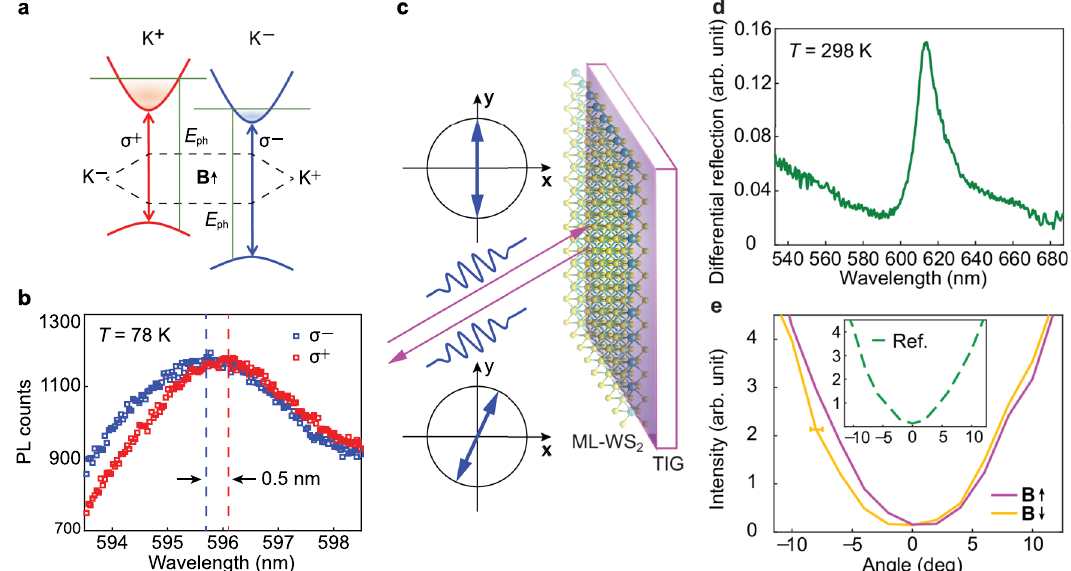
Fig. 3 Magneto-optical effects in a monolayer WS 2 on TIG. a The time-reversal symmetry breaking with an out-of-plane exchange magnetic fi eld provided by TIG induces a spectral splitting and an intensity difference between σ − (blue) and σ + (red) in the ML-WS 2 under the pumping of E ph . b The observed splitting of ~0.5 nm (~1.7 meV) corresponds to an exchange magnetic fi eld of ~7 T at the temperature of 78 K from the TIG. The splitting is estimated to be ~0.2 nm that is hardly measurable in spectra with the reduced exchange magnetic fi eld of ~2.7 T at 298 K. c An alternative method to characterize the magneto-optical effect (Fig. 1C) is using the rotation of linear polarization (blue arrows) of light upon re fl ection. d A differential re fl ection spectrum, de fi ned as the difference in re fl ectance of the sample (WS 2 ) and substrate (TIG) normalized to that of a reference (silver mirror), consists of a peak of light-matter interaction at the wavelength of ~617 nm. e Analysis of the polarization of re fl ected light from WS 2 at 617 nm with up (purple) and down (yellow) magnetic moments. The 0° represents that the polarization of the output and input light is the same. The minima of curves designate the polarization of the outgoing light showing a rotation angle of ~2° compared to that of the input light. By fl ipping the exchange magnetic fi eld ( B ↑ and B ↓ ), the rotation angle changes the sign indicating that the rotation is due to the magneto-optical effect. In the absence of the exchange magnetic fi eld, the polarization of the light re fl ected from a reference silver mirror (inset) is the same as that of the input light, which manifests as the minimum at 0°, further con fi rming the magneto effect being the origin of the rotation. The error bar of ±0.5° is system